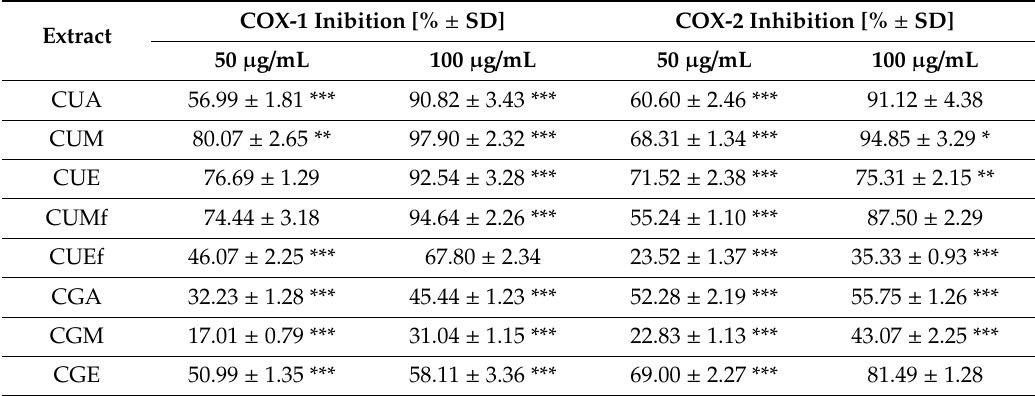
Table 3. Inhibition of COX-1 and COX-2 activity of the C. uralensis and C. gigantea